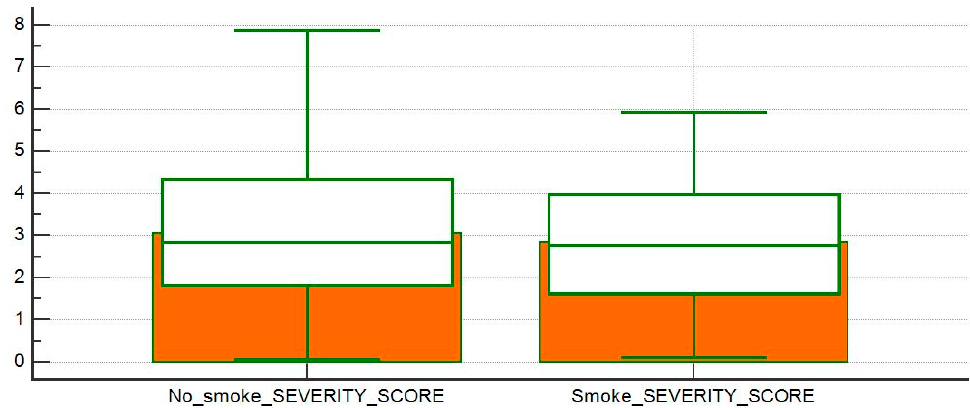
Figure 3. Comparison of severity score averages between exposed and non-smoking patients.